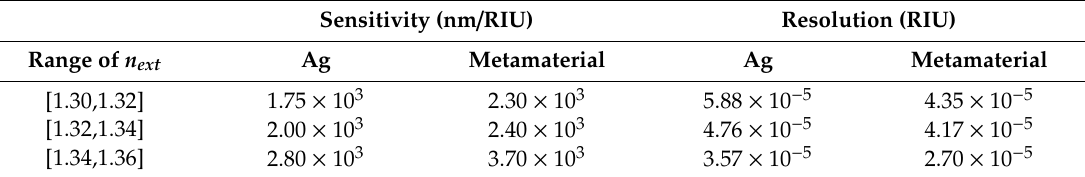
Table 3. Sensor sensitivity and sensor resolution for the D-type SPR refractive index optical fiber sensor with two di ff erent films, silver and the metamaterial with 80%Ag and 20%Al 2 O 3 ,